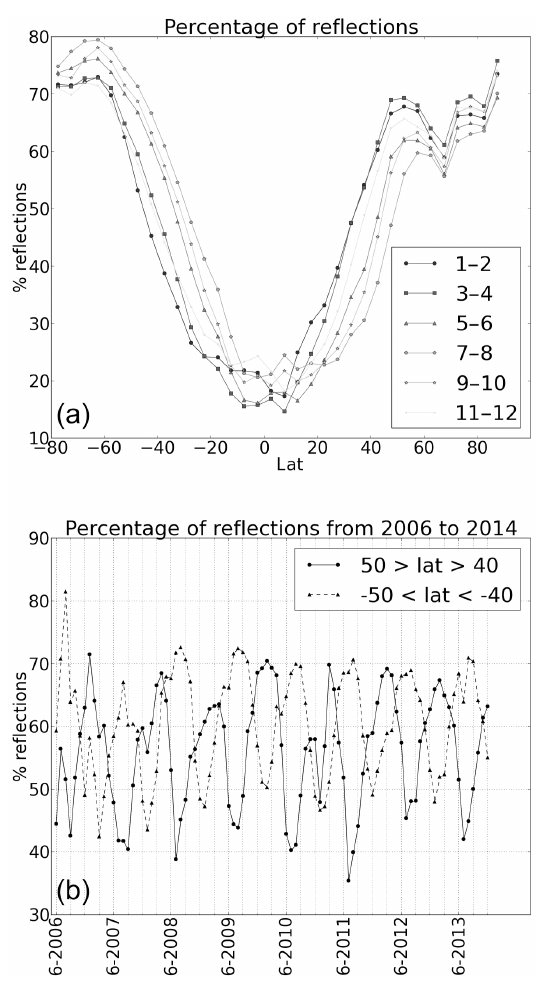
Figure 7. Statistics of reflection occurrence in events over ocean ob- tained with the COSMIC constellation from 2006 to 2014. (a) Per- centage reflections as a function of the latitude (degrees), binned by bands of 5 ◦ , over all 6 bi-monthly groups in the year. The curve shows a shift northwards during boreal summer and southwards during austral summer. (b) Monthly time series of percentage re- flections in the northern and southern midlatitude belts, between 40 and 50 ◦ , showing the seasonal variation and its opposite phase in each